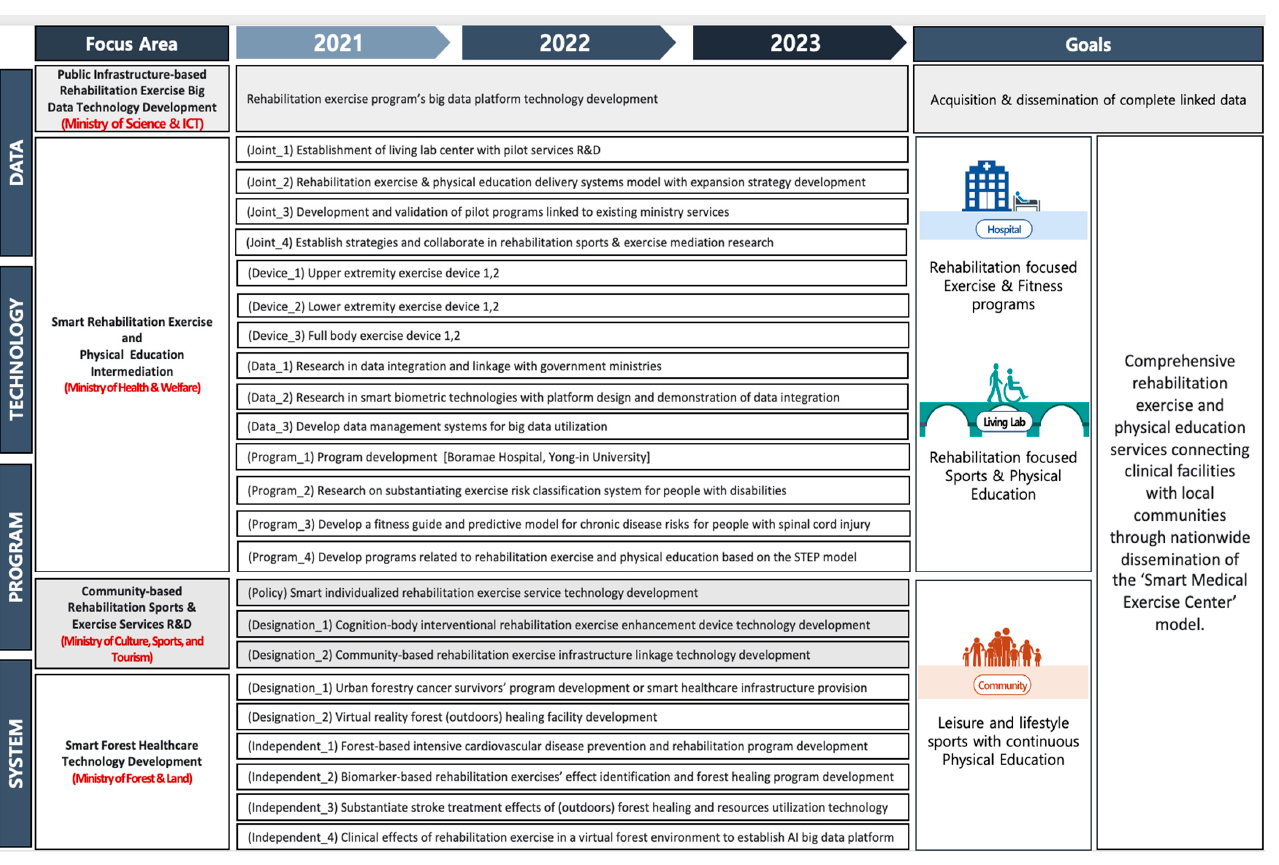
Figure 3. Focused research areas—system, program, technology, and data with respective projected goals—overseen by respective South Korean government ministries.